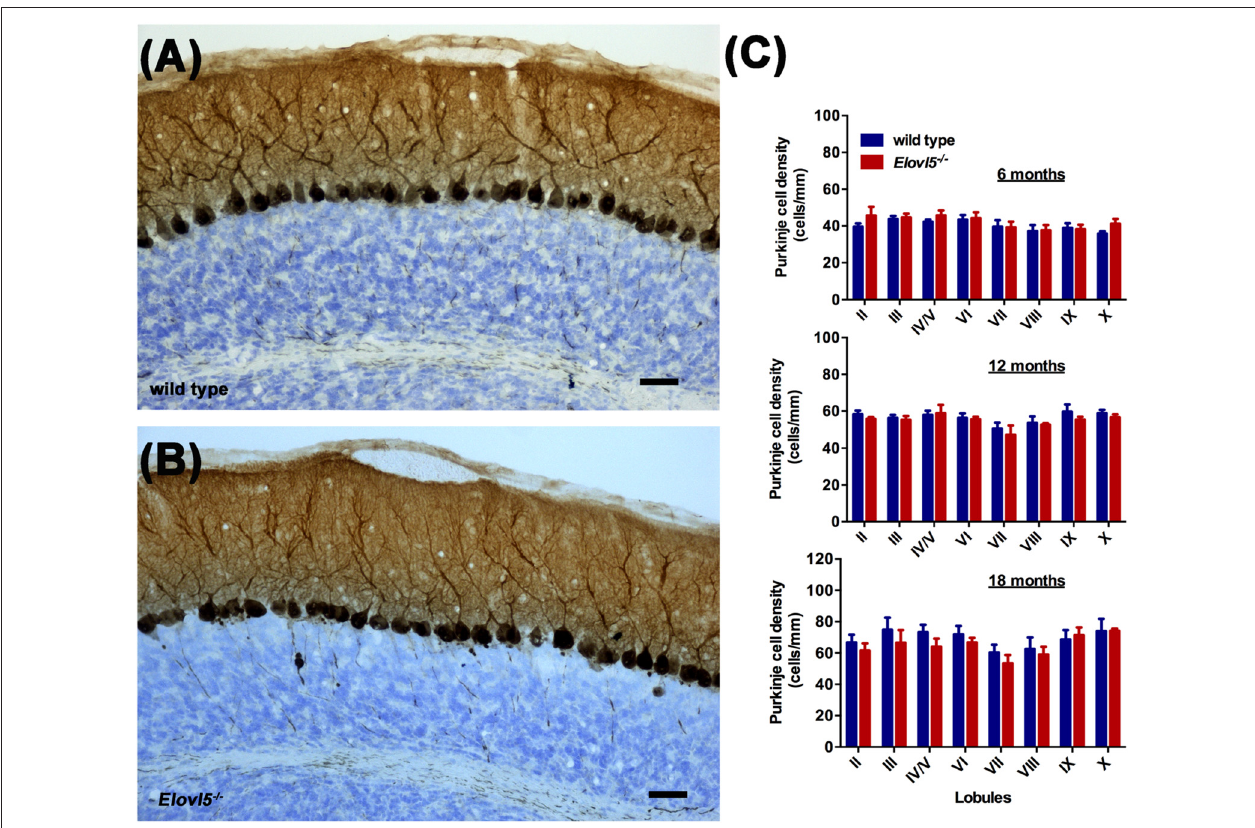
FIGURE 5 | Normal PC density in the cerebellum of Elovl5 − / − mice. Calbindin staining of sagittal cerebellar sections obtained from (A) wild type and (B) Elovl5 − / − mice. (C) PC density analyzed at 6, 12 and 18 months of age in both genotypes. Scale bar 40 µ